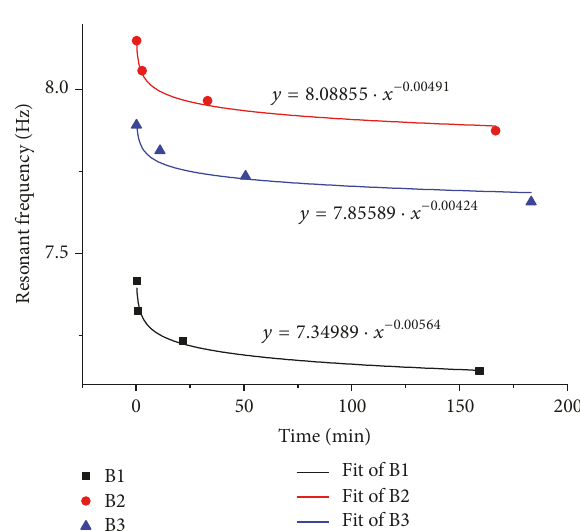
Figure 18: The variation and fitting curves of resonant frequency in Group B.